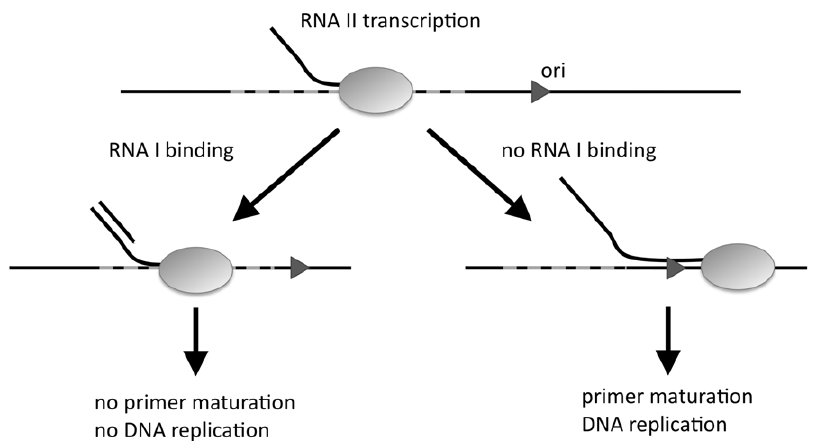
Figure 1. Replication control of ColE1-type plasmids. The first step of plasmid replication is the transcription of a replication primer, RNA II. If the replication regulator, RNA I, binds to the nascent RNA II within the ‘inhibition window’ (dashed area) upstream of the replication origin (ori), maturation of the primer is inhibited and DNA replication is suppressed. Otherwise, the primer matures and DNA replication can initiate.